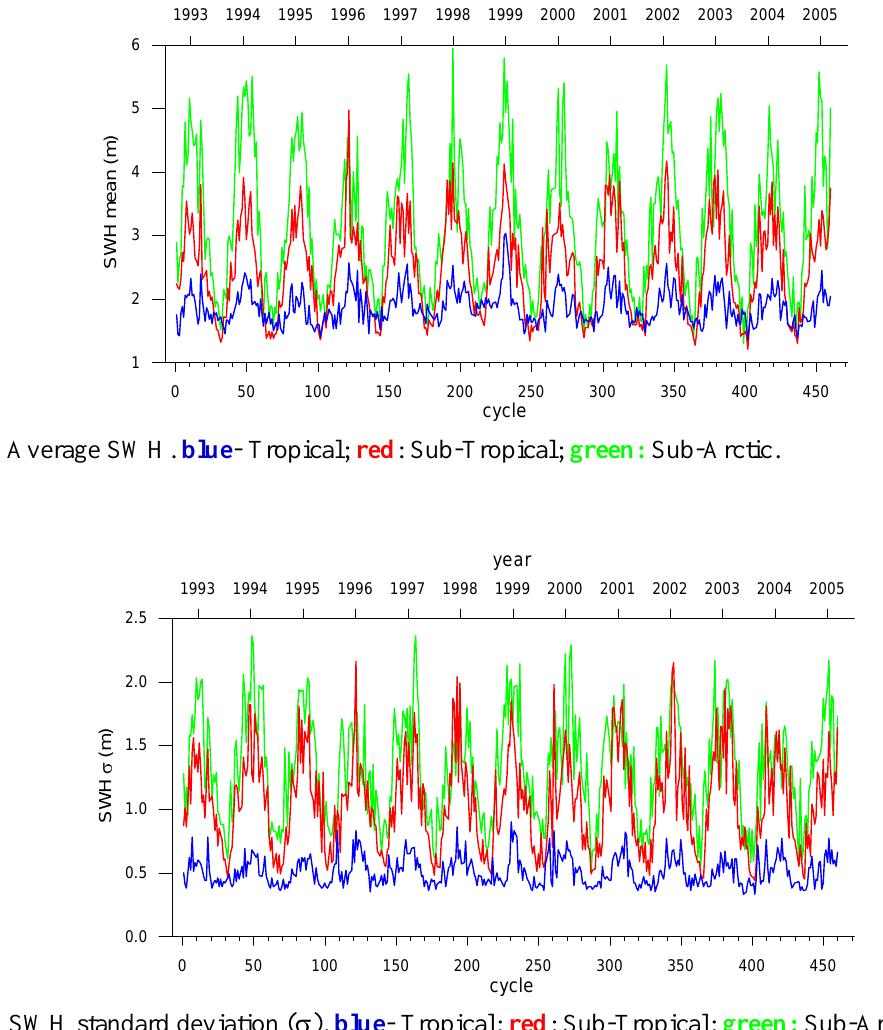
Figure 13b – SWH standard deviation ( σ ). blue - Tropical; red : Sub-Tropical; green: Sub-Arctic.